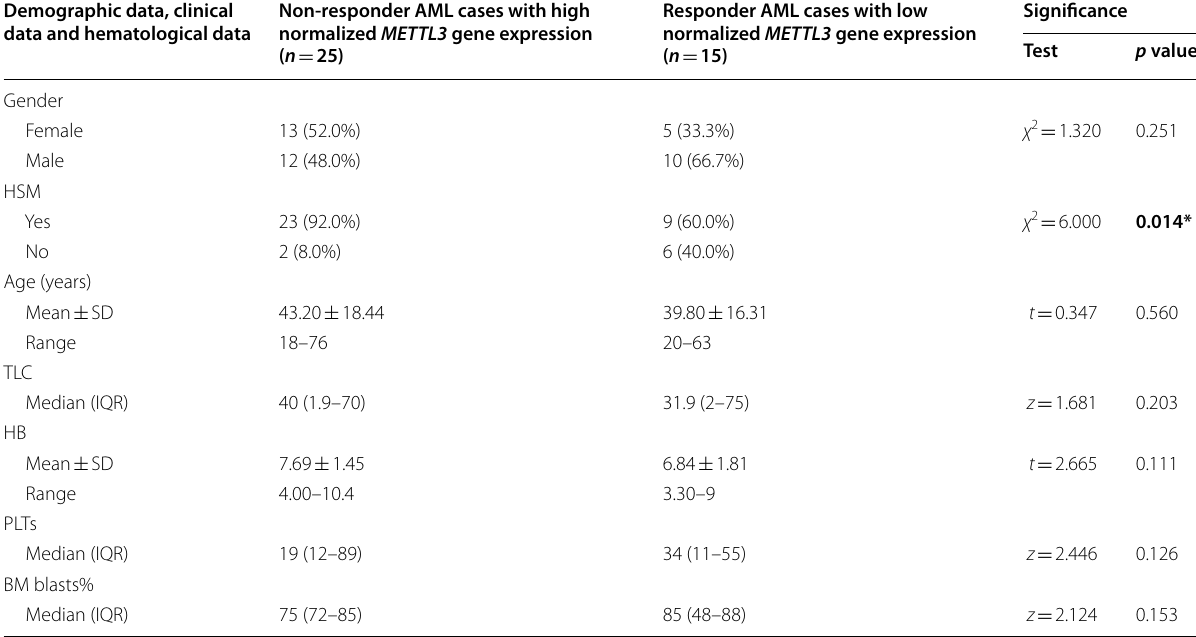
HSM hepatosplenomegaly, TLC total leucocyte count, HB hemoglobin, PLTs platelets, χ 2 Chi-square test, t independent sample t test, z Mann–Whitney test * p value < 0.05 S; p value > 0.05 NS Bold value is the only statistically significant p value